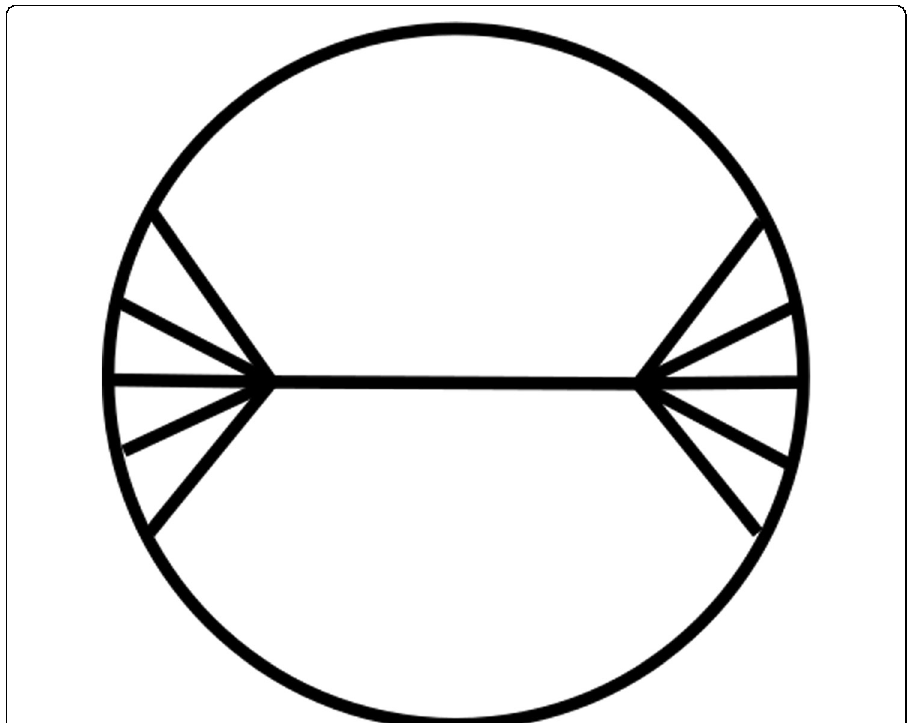
Fig. 4 Legend: The diagonal lines show how different associates converge, the horizontal line presents the common time and